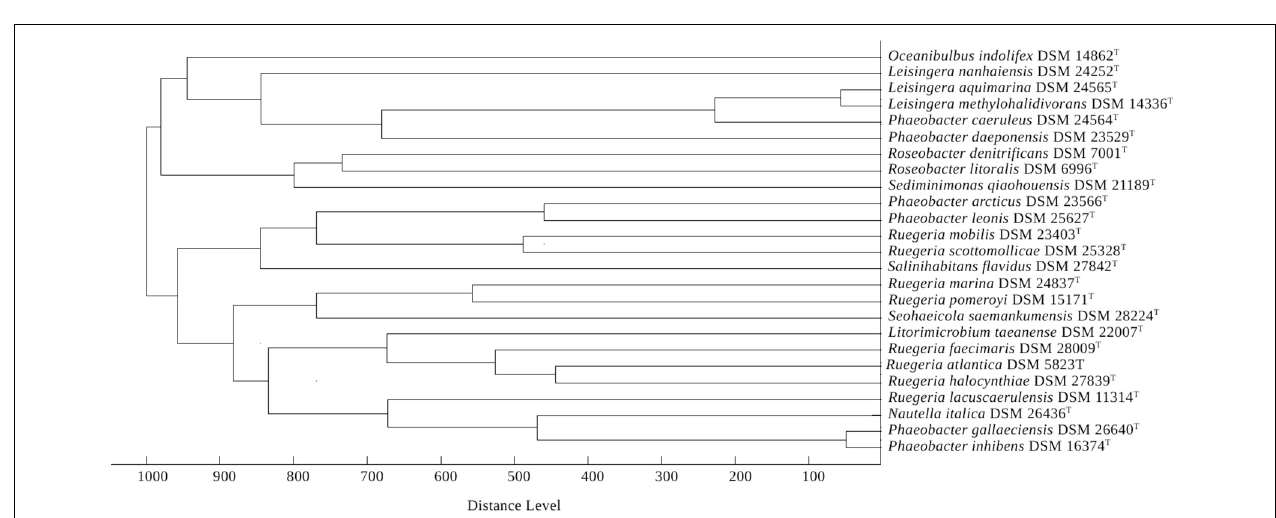
above the branches (from left to right) are bootstrapping support values (if larger than 60%) from (i) constrained ML, (ii) constrained maximum-parsimony (MP), (iii) unconstrained ML, and (iv) unconstrained MP analysis. Values larger than 95% are shown in bold; dots indicate branches with maximum support under all settings.